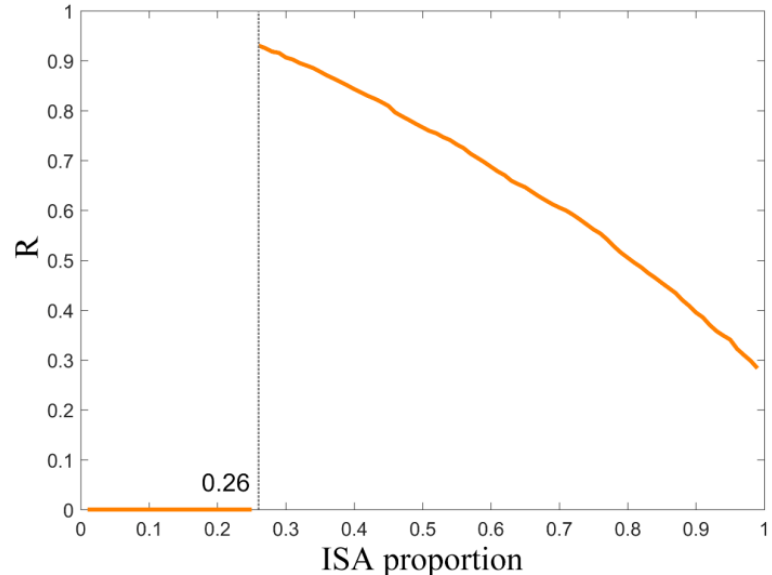
Figure 12. Effect of ISA proportion threshold on accuracy under fixed threshold [ – 0.0558, 0.1462].